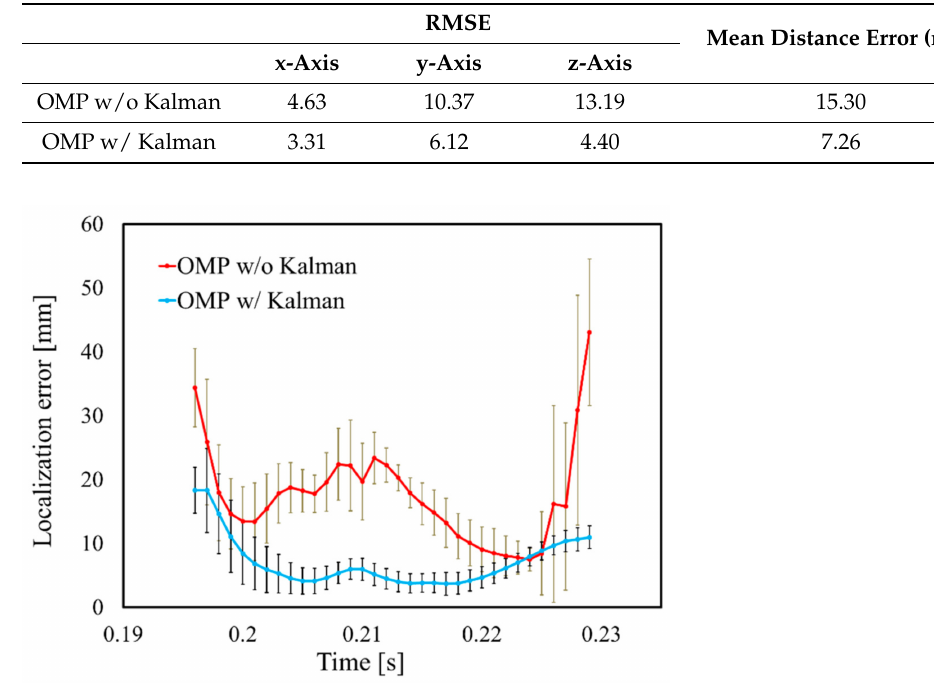
Figure 13. LE on R-wave time step with SNR = 20 dB. Error bars represent standard